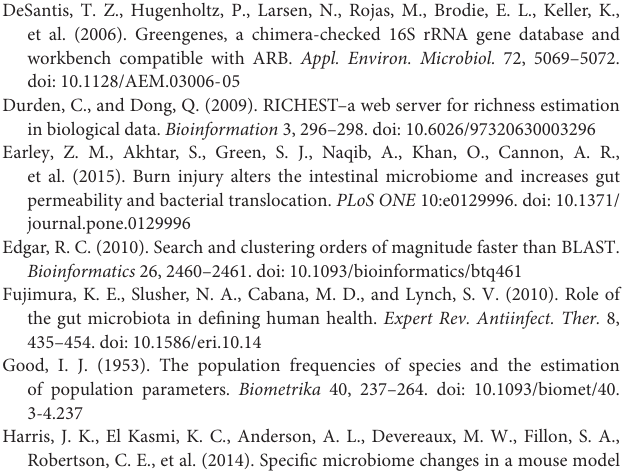
FIGURE S3 | Comparison of the number of phyla in the two groups. A paired t -test was used for the statistical analysis and the p -value obtained was 0.4642. FIGURE S4 | Firmicutes/Bacteroidetes ratio comparison of the two groups. ∗ p < 0.05. TABLE S1 | α -diversity indexes for each sample. TABLE S2 | ALL the phyla, classes, orders, families, and genera that changed in this study. TABLE S3 | All samples at genus